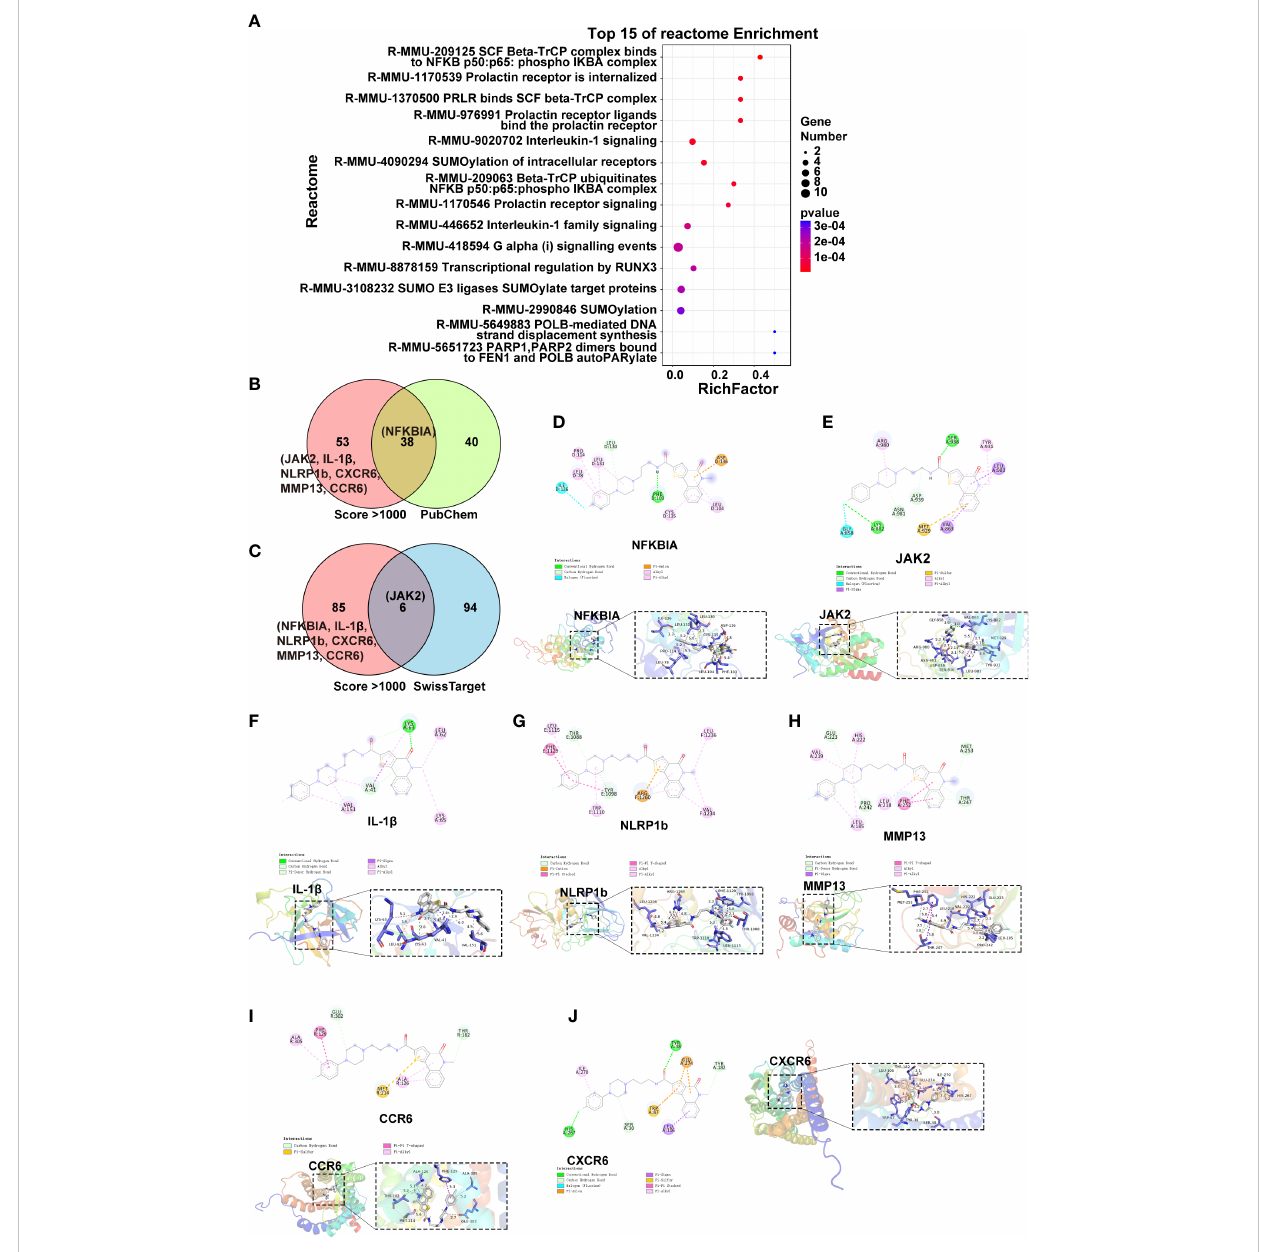
FIGURE 7 C498 putative drug targets. (A) , The Reactome analysis of 89 targets (score > 1000) of C498. (B) , Venn analysis of PubChem Biological Test and target fi shing results. (C) , Venn analysis of target fi shing results and SwissTarget predicted targets. (D-J) , The docking results were made separately in 2D and 3D plots using Pymol (2.3) and Discovery